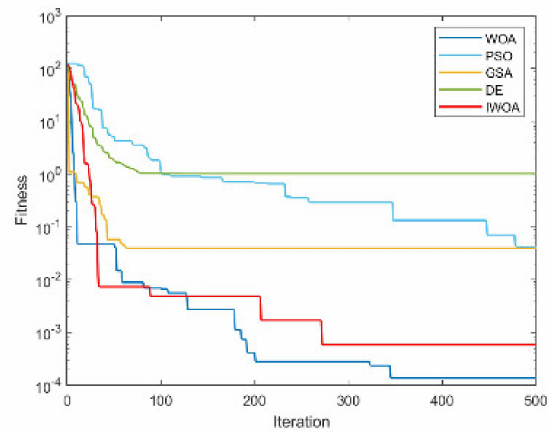
Figure A4. The convergence curve for solving F4.